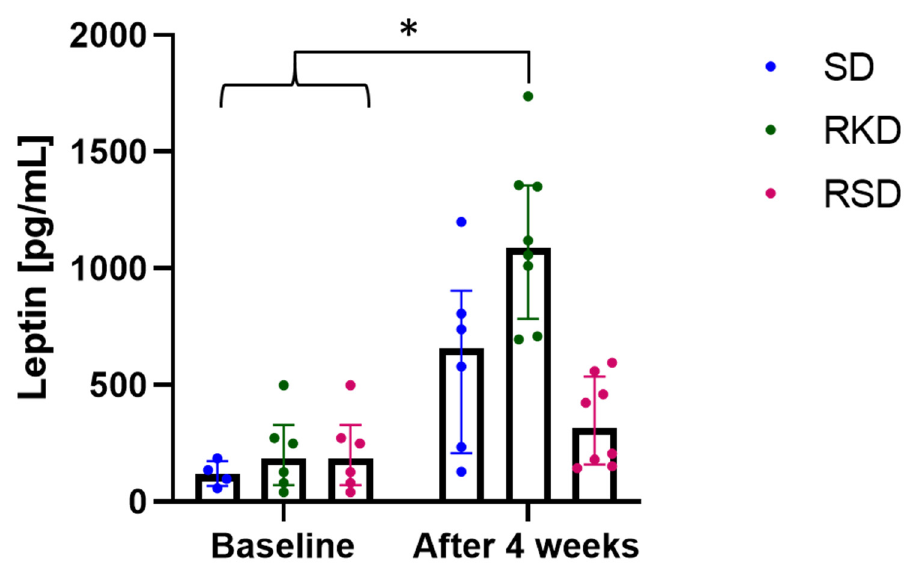
Figure 3. The status of leptin before and after the nutritional intervention. The bars represents the median with the error bars representing interquartile range (Q1; Q3). The significant differences are marker with “*”.